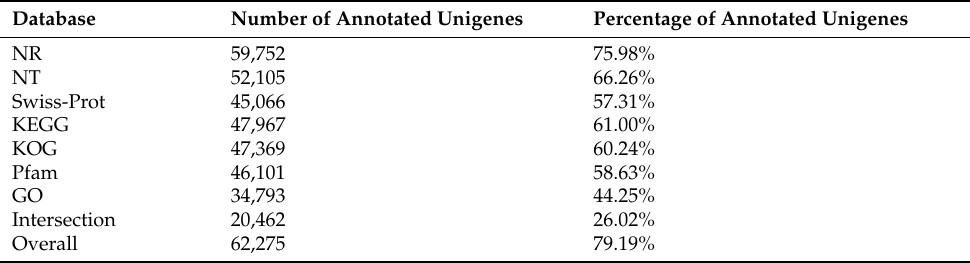
Table 2. Functional annotation of the unigenes in different databases.